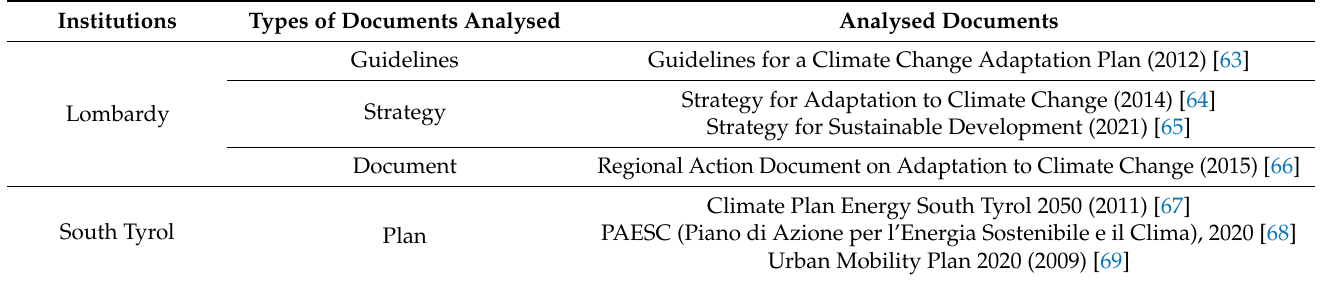
Table 2. The list of documents elaborated at the regional level for case